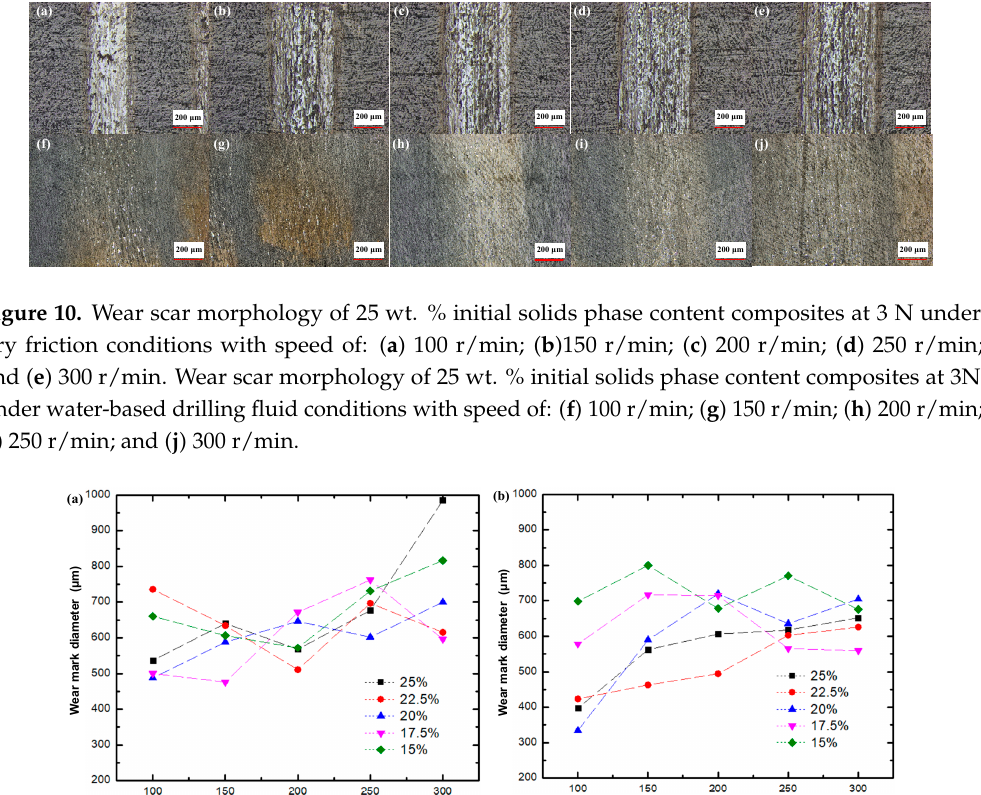
steel ball leading to abrasive and corrosion wear. Therefore, the friction coefficient is higher.